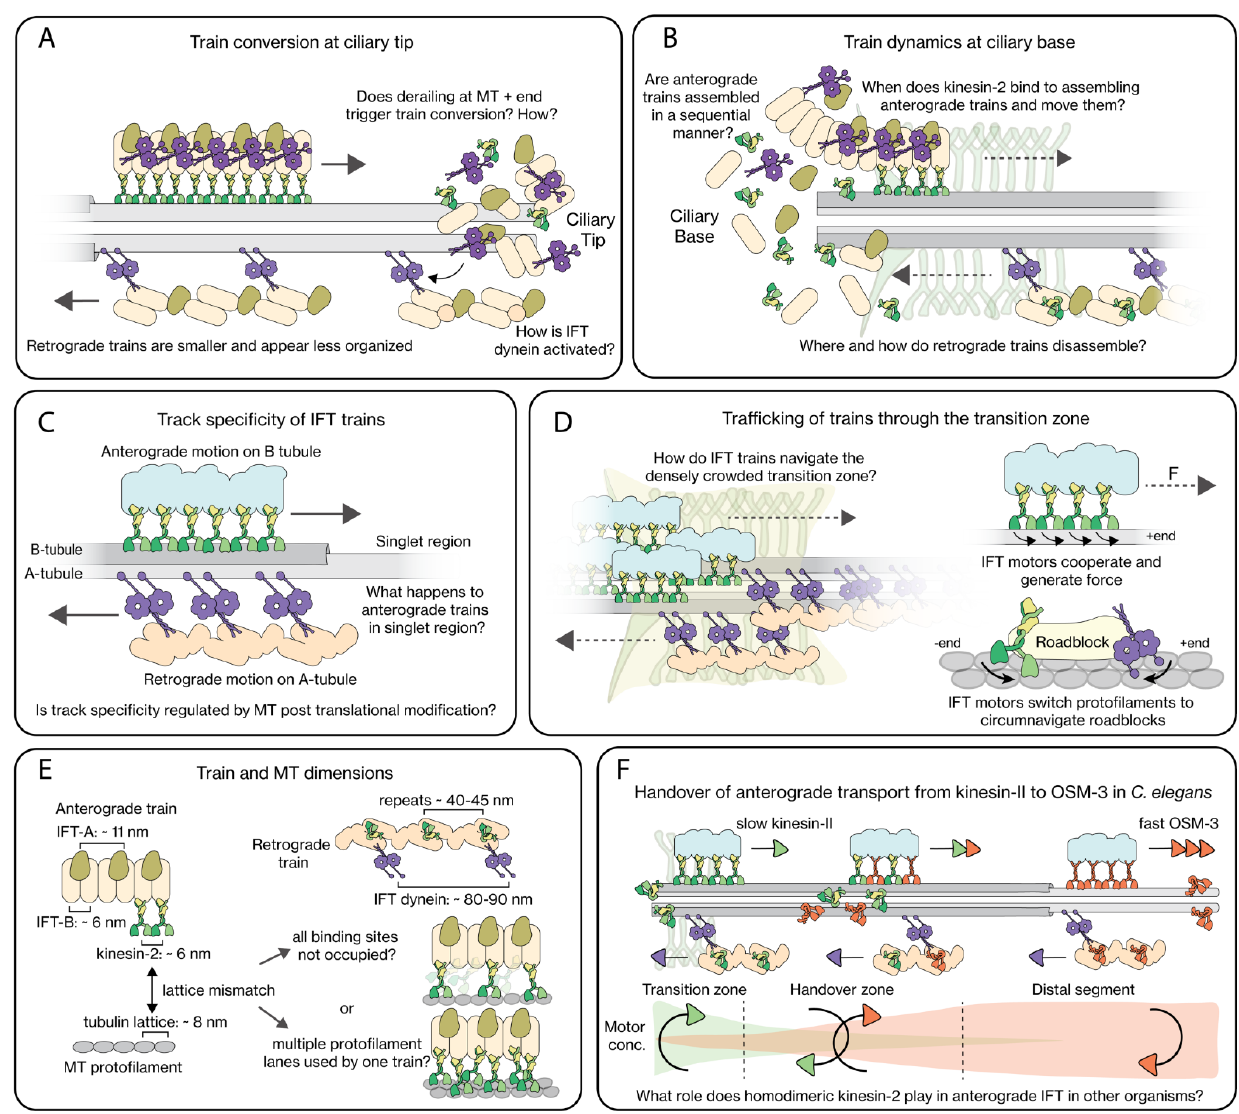
Figure 4. Mechanistic insights into different aspects of IFT. ( A ) At the ciliary tip, highly structured anterograde trains get converted to smaller and less ordered retrograde trains. It is still unclear how this conversion is orchestrated, and how IFT dynein switches from an autoinhibited to the active state. ( B ) At the ciliary base, large anterograde trains are assembled, possibly in a sequential manner, with activated kinesin-2 motors dragging them into the cilium after they are assembled. Little is understood of retrograde train disassembly at the base. ( C ) In Chlamydomonas , anterograde trains move along the B-tubule while retrograde trains move along the A-tubule of MT doublets. ( D ) IFT motors have to navigate IFT trains through a densely crowded transition zone. The IFT motors can generate force and are capable of circumnavigating roadblocks by switching protofilament lanes, which likely allow them to handle this. ( E ) Anterograde trains have kinesin-2 binding sites every ~6 nm, while MT protofilaments have tubulin repeats every 8 nm. This implies that, at any given time, not all kinesin-2 motors engage with the MT lattice and/or kinesin-2 motors use multiple protofilament lanes to transport an anterograde train. IFT-dynein motors bind ~80–90 nm apart from each other on retrograde trains. ( F ) In C. elegans , anterograde trains are driven across the transition zone by the slower heterotrimeric kinesin-2 (kinesin-II), after which trains are gradually handed over to the faster homodimeric kinesin-2 (OSM-3), which carry the trains to the ciliary tip. The role played by homodimeric kinesin-2 in other organisms is not well